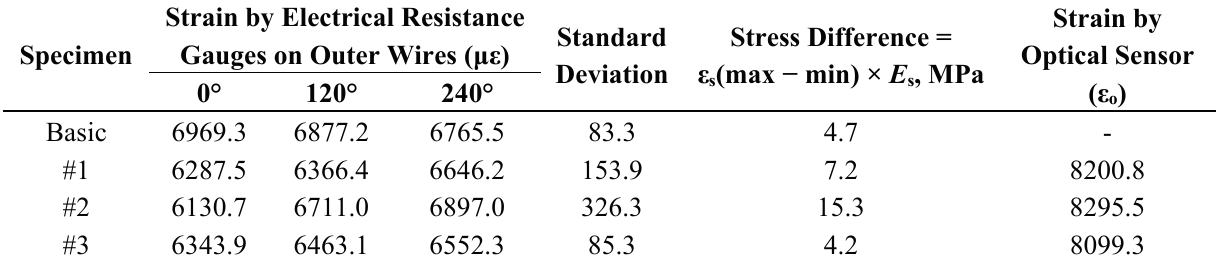
Table 2. Comparison of strain at prestress force of 200 kN.